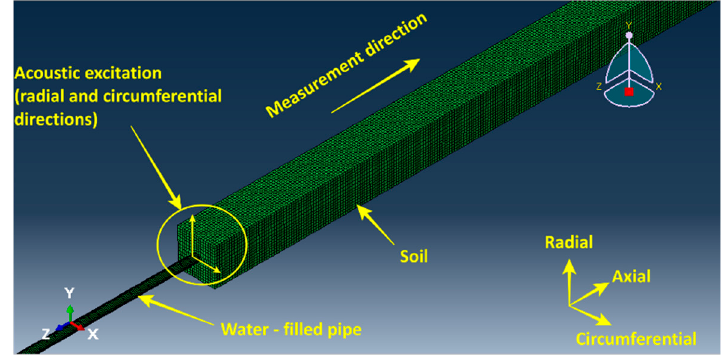
Figure 1. Buried MDPE pipe showing the acoustic excitation directions and surrounding soil.